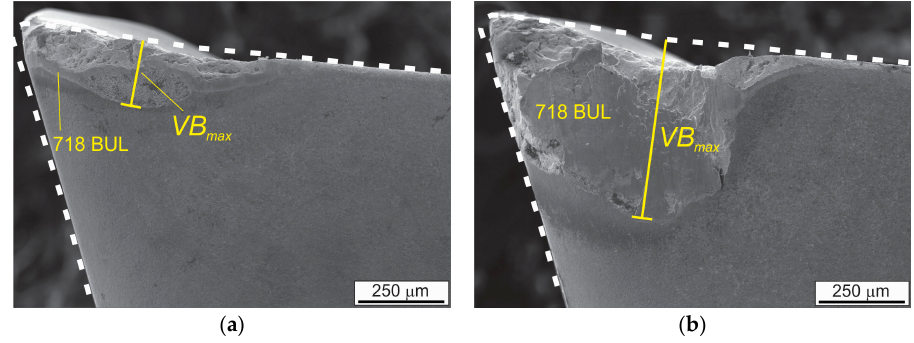
Figure 6. Scanning electron microscope (SEM) images of Tool wet1 side flank face with zero pass edge outline (ZPEO): ( a ) after the third pass, and ( b ) after the fourth pass.